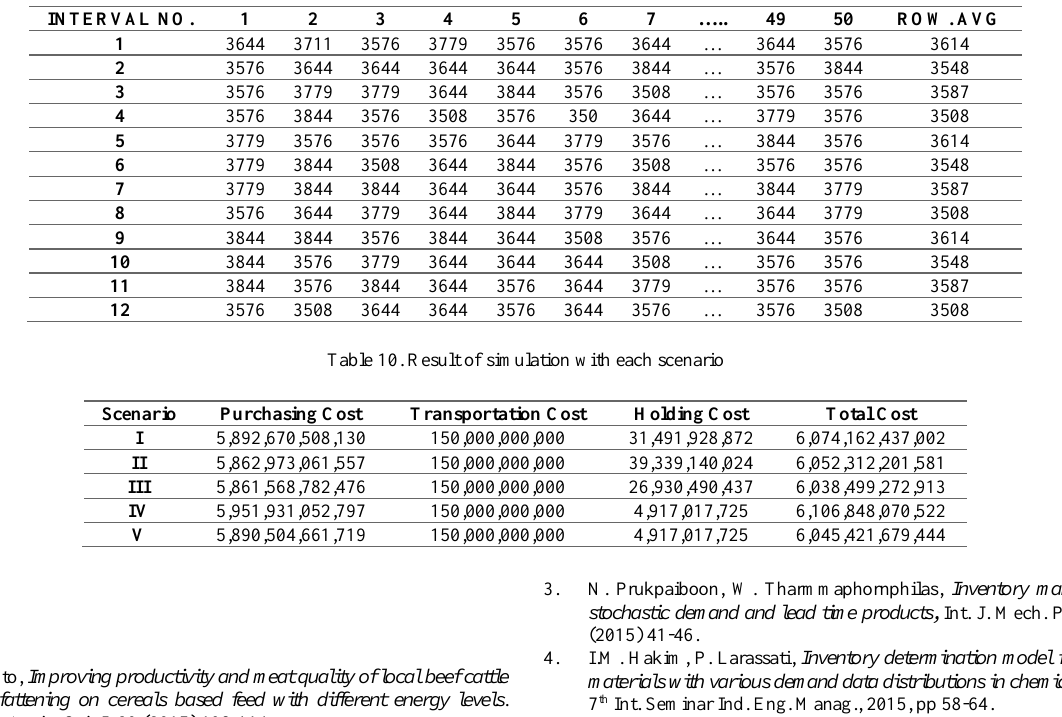
Table 9. Data of purchase price simulation for 12 months